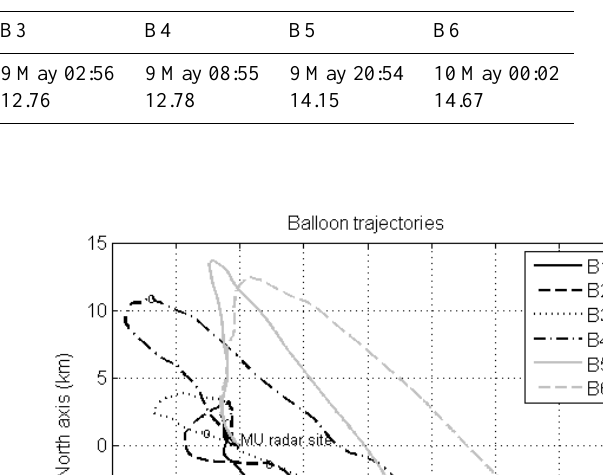
Table 1. Launch time (LT) of the 6 GPS balloons and the tropopause height from temperature